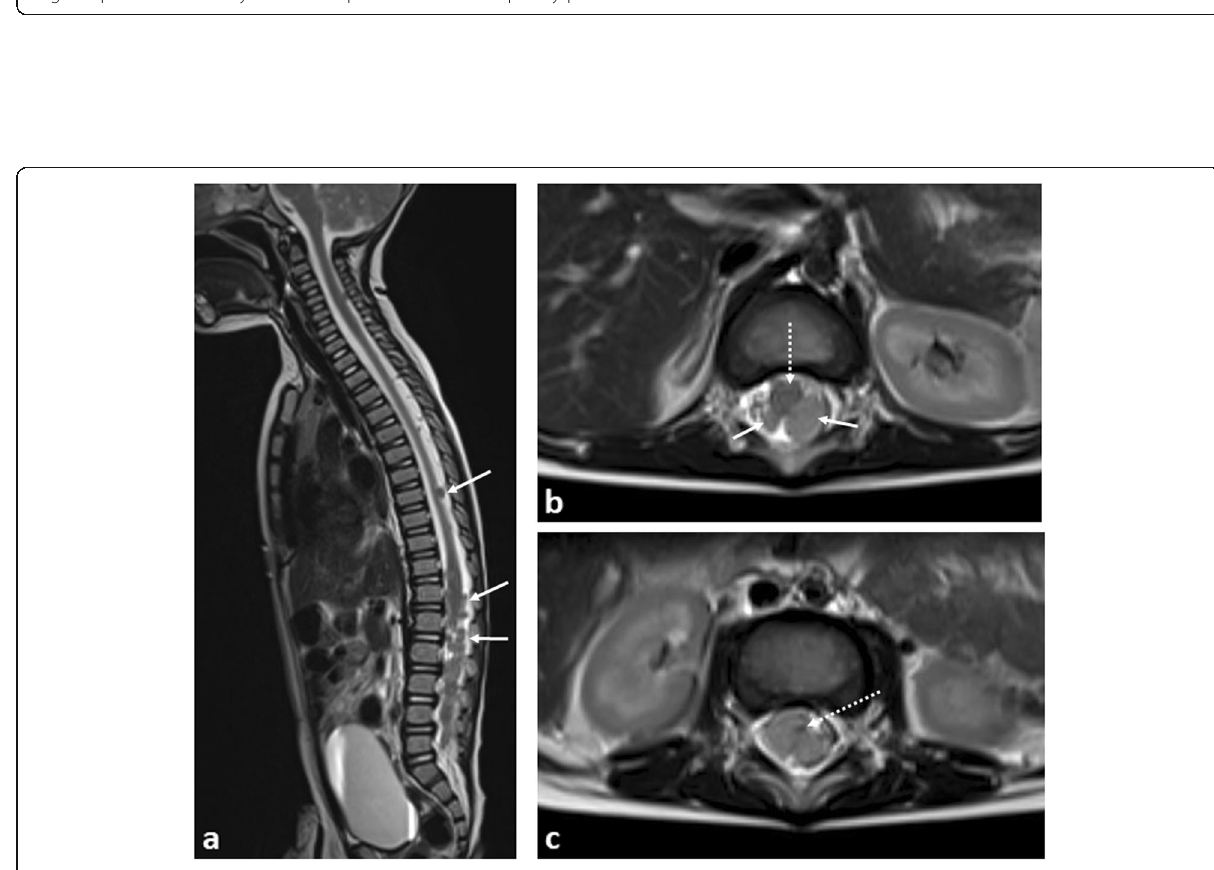
Fig. 2 A 9-month-old boy with paravertebral dumbbell neuroblastoma. a Sagittal T2-weighted fat-saturated MR image shows a large soft tissue mass occupying and expanding the spinal canal from T12 to S3 levels (arrows), also causing compression of the spinal cord. b Axial T1 post- contrast imaging reveals a large right paravertebral mass (arrows) with intraspinal extension, occupying the entire right-sided neural foramen. Urgent spinal laminectomy and decompression was subsequently performed